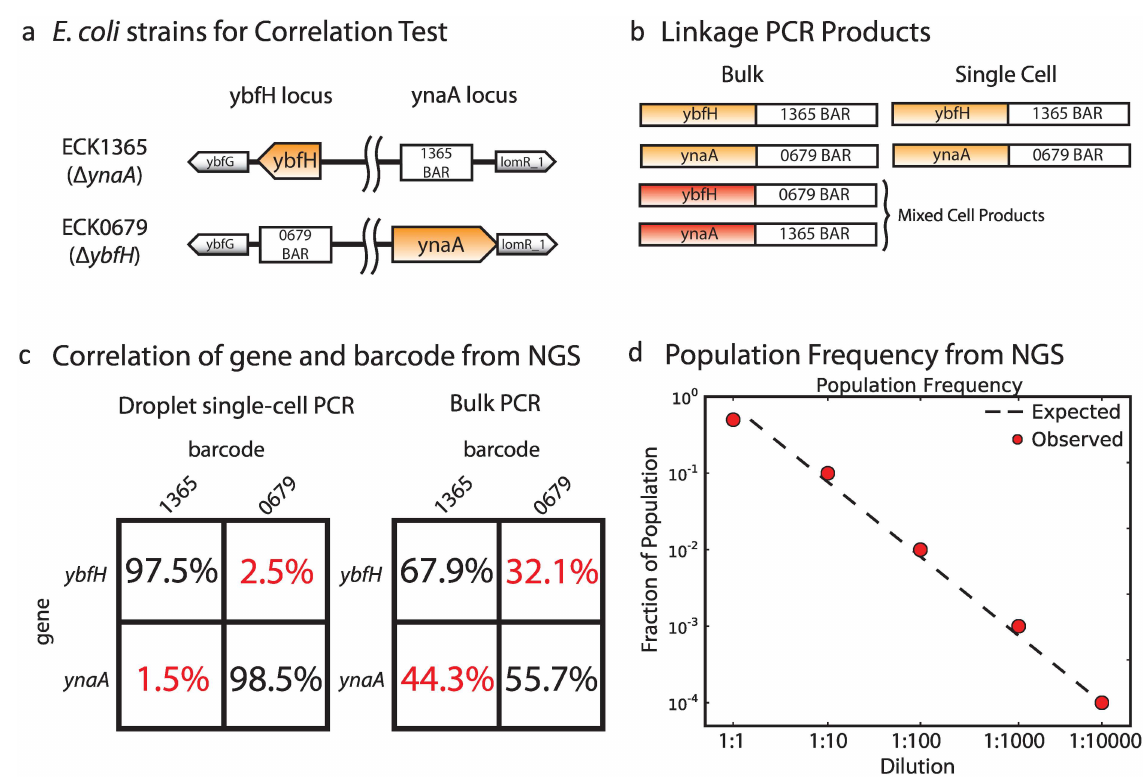
Fig 2. Droplet based single-cell sequencing preserves genomic structure and population membership. (a) KEIO collection strains of E . coli used to test linkagePCR: a barcodehas beeninserted into the genomeat definedloci, creating gene knockouts of ynaA and ybfH in strains ECK1365and ECK0679, respectively. (b) LinkagePCR to fuse the sequencefrom both genomicloci in the two strains yields a mixture of four products in bulk (left), two of which reflect the true genomicorganization and two that reflect spurious mixed cell products. However, single-cell linkagePCR (scLPCR) only yields the two products that reflect true genomic organization.(c) Deep sequencing of products from bulk linkagePCR or scLPCR showingpercent of reads that reflect true genomic organization(in black) or spurious mixed cell products (in red), indicating the scLPCR on a culture of mixed cell types recovers reports on the genomicvariationwithin the population. (d) The fraction of the populationdeterminedby sequencing depth (red dots) when one KEIO strain is spiked into a culture of the other strain at defineddilutionsshown on the x-axis. The expectedresults are shown as a dashedline.